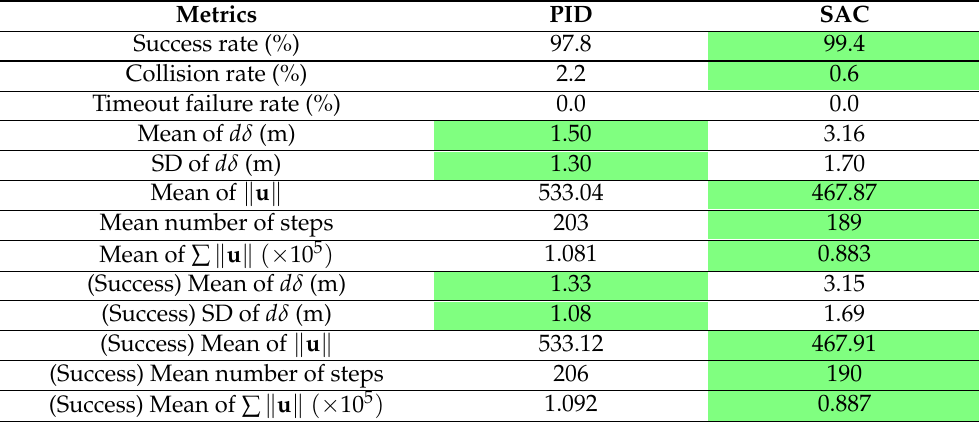
Table 5. Testing phase of a model after removing the position vector, the Euler angles, and the pitch error from the state vector, trained on 1300 episodes. For each metric, the controller with the best score is highlighted in green.